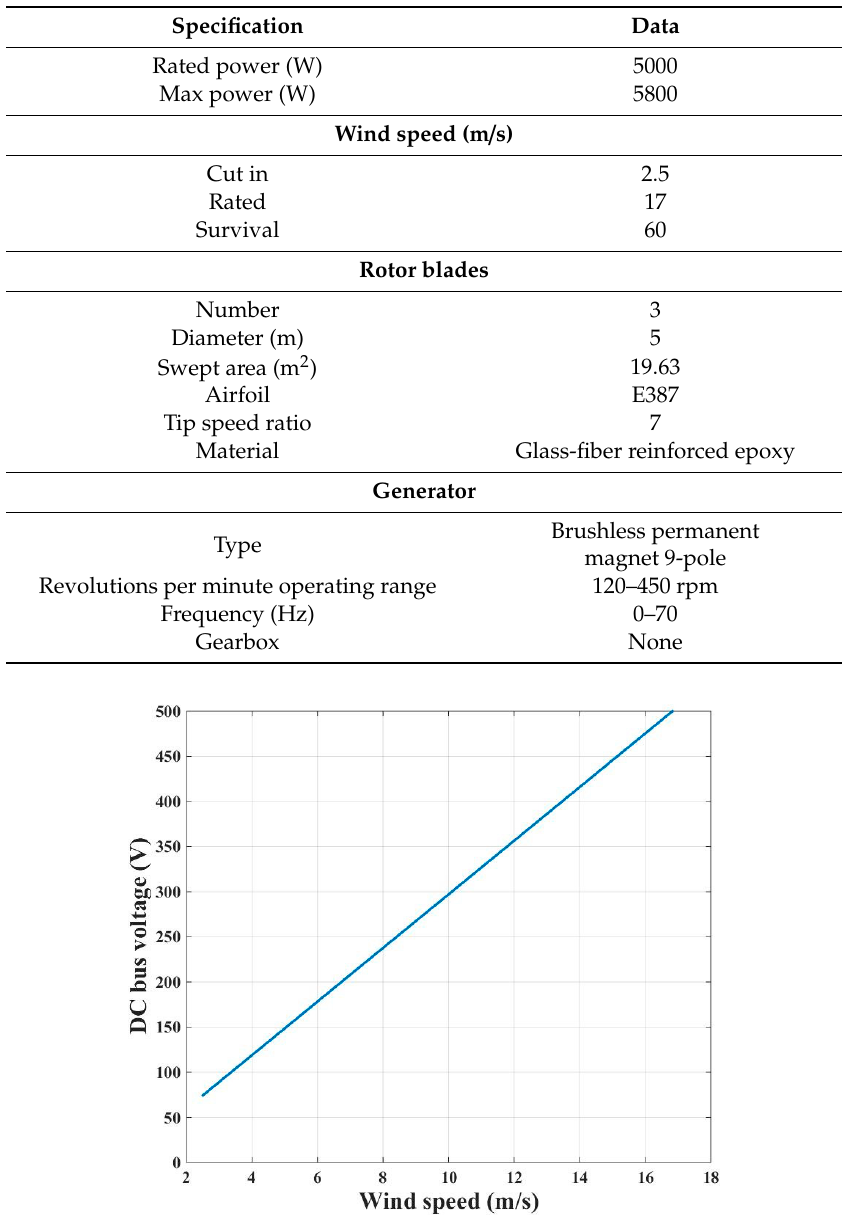
Figure 2. The DC voltage available at the output of the rectifier versus the wind speed.